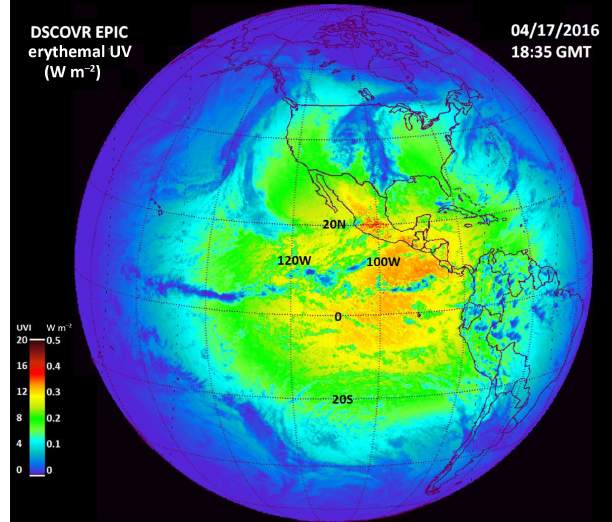
Figure 17. Erythemal irradiances calculated from Eq. (13) and from the EPIC ozone and LER data obtained on 17 April 2016 at 18:35 UTC. The scale shows both the irradiance values in watts per square meter (Wm − 2 ) and the UV index ranging from 0 to 20. This scene is centered over the Pacific Ocean and shows a peak UV index of about 15. Since this period is close to equinox, the sun is nearly overhead just north of the Equator with solar noon at 98.75 ◦ W lon- gitude and overhead near 10 ◦